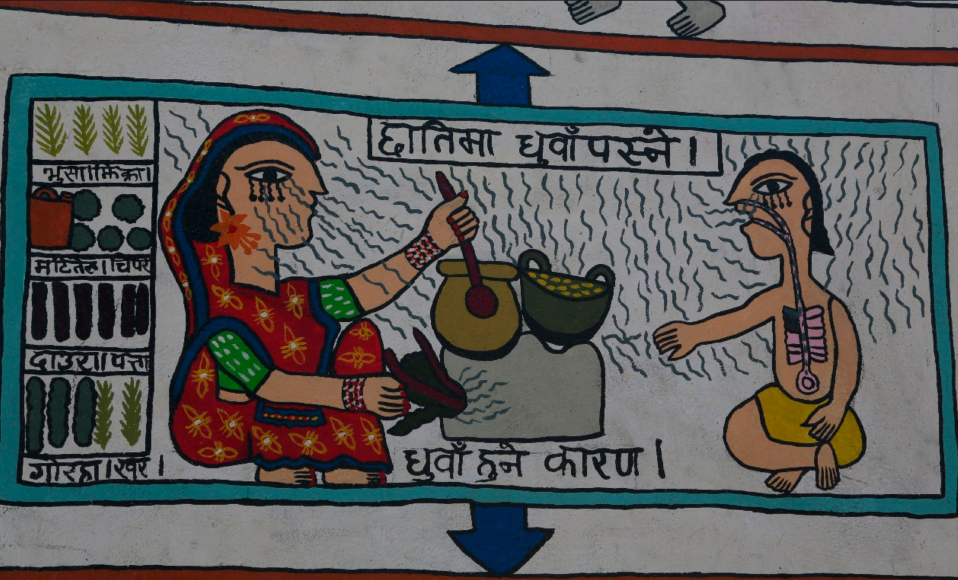
Figure 1. The effect of air pollution on the eyes and lungs. Translation: Top line = “smoke entering the chest. Bottom line = cause of smoke”. The picture shows some of the health effects of air pollution, including streaming of the eyes and damage to the